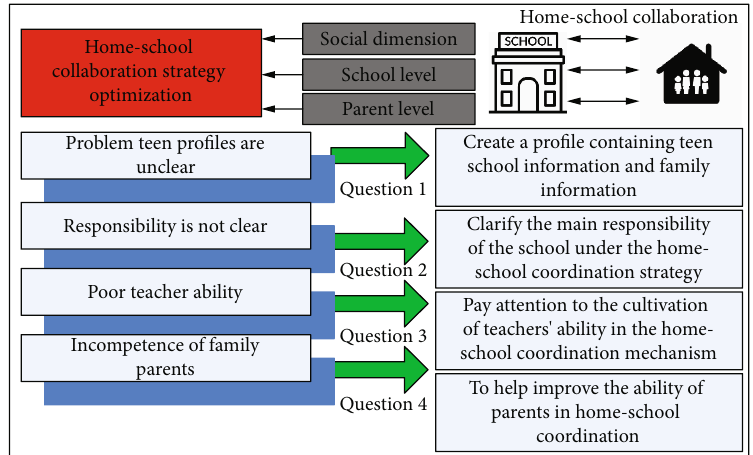
Figure 2: Guiding framework of current home-school collaboration strategy problem analysis and optimization